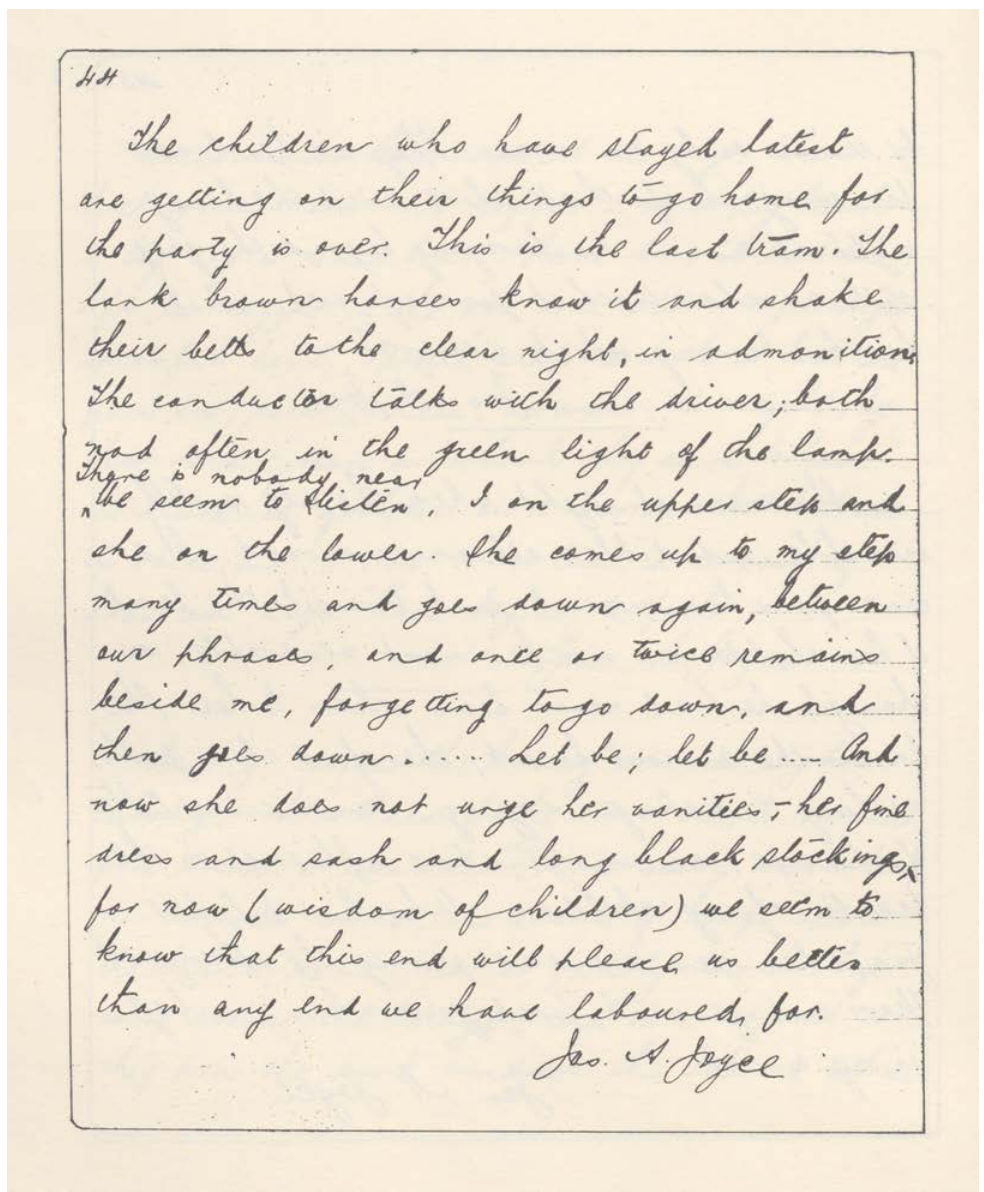
Figure 2 – ‘Epiphany 3’ by the Joyce (1991) numbering. The James Joyce Archive , Groden et al. 1977-1979, vol. 7,